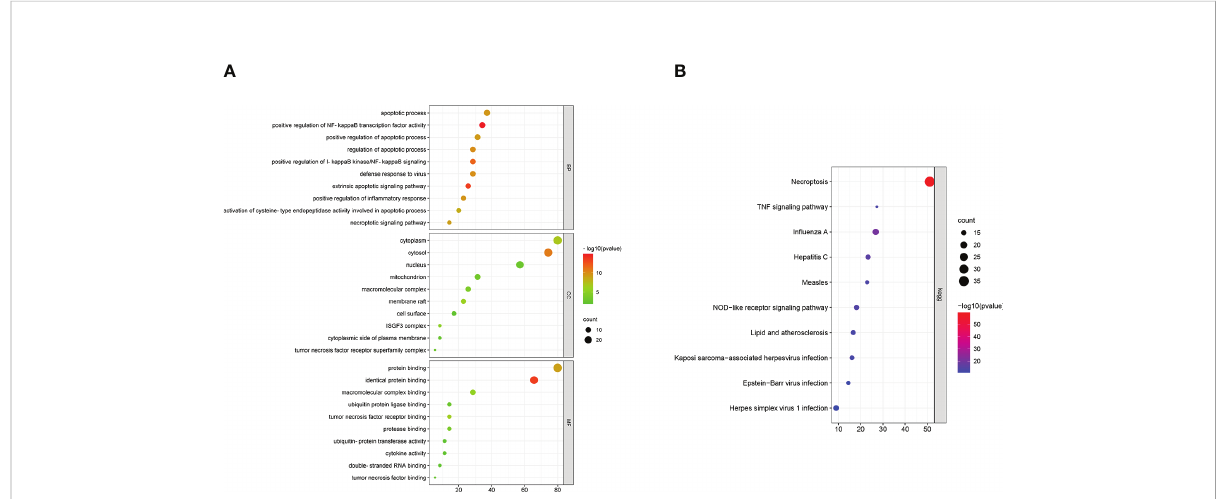
FIGURE 6 Enriched GO terms and KEGG pathways based on functional enrichment analyses of the necroptosis-related differentially expressed genes (NRDEGs). (A) Enriched BP, MF, and CC terms in the GO enrichment analysis of NRDEGs. (B) Enriched KEGG pathways represented by the